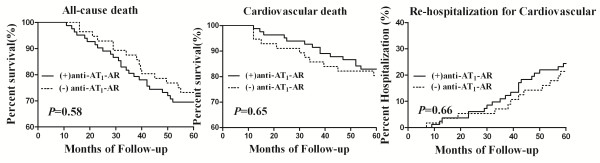
Endpoint events in both groups over 5 years. There was no significant difference in total mortality, cardiovascular mortality, or re-hospitalisation for a protocol-specific cardiovascular cases between patients with (+) anti-AT1-AR and (−) anti-AT1-AR (all P > 0.05).